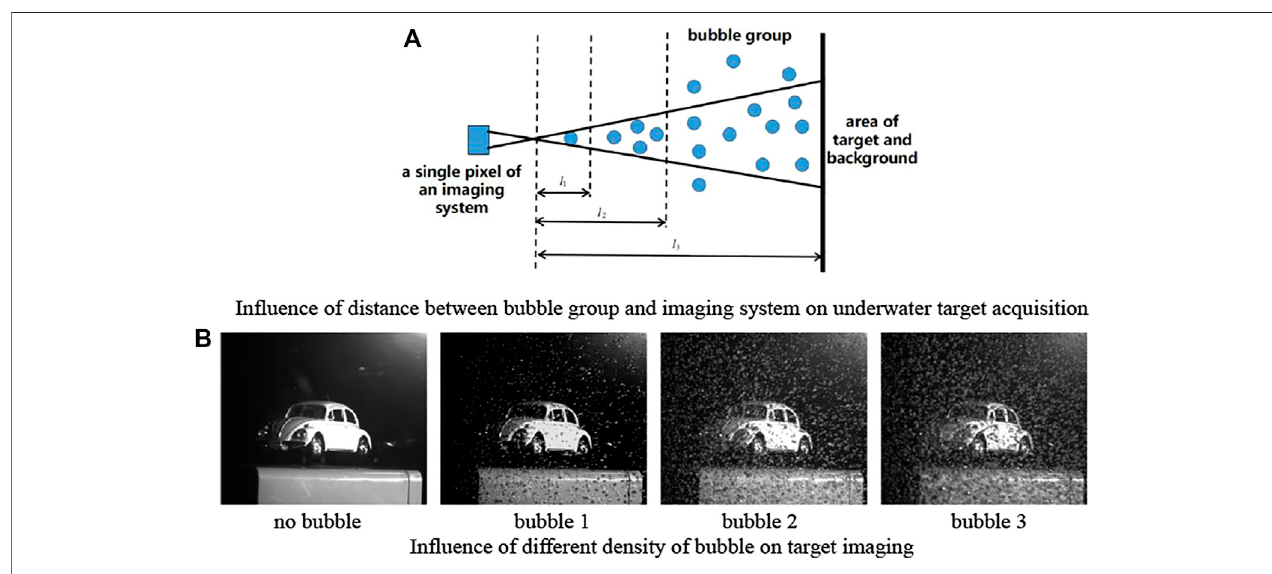
FIGURE 6 | Exploration of in fl uence of bubble group on underwater target acquisition. (A) In fl uence of distance between bubble group and imaging system on underwater target acquisition (B) In fl uence of different density of bubble on target imaging.